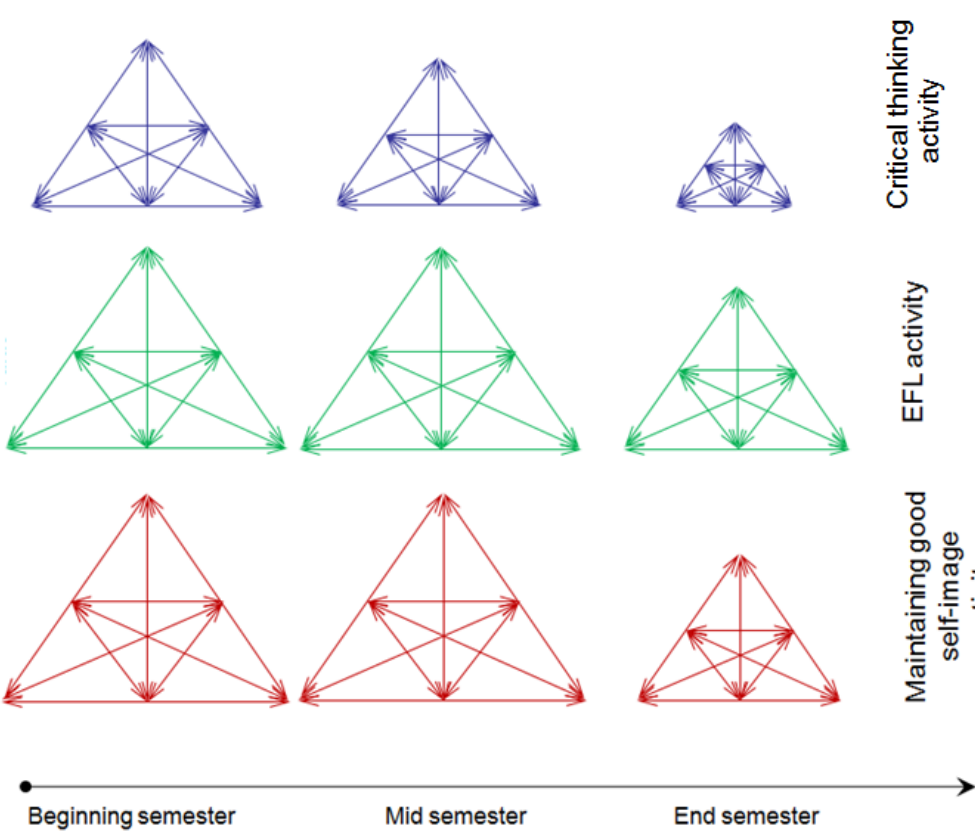
Figure 7 . Illustration of the historicity of Azita‘s activity systems in the